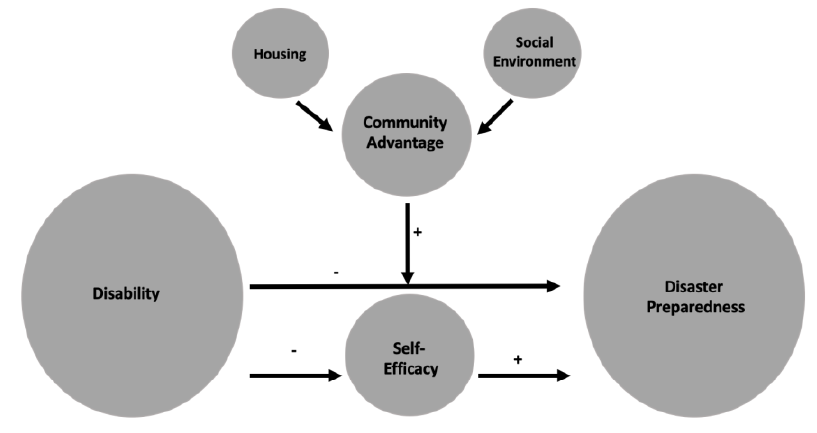
Figure 3. Revised conceptual model linking disability and disaster preparedness.